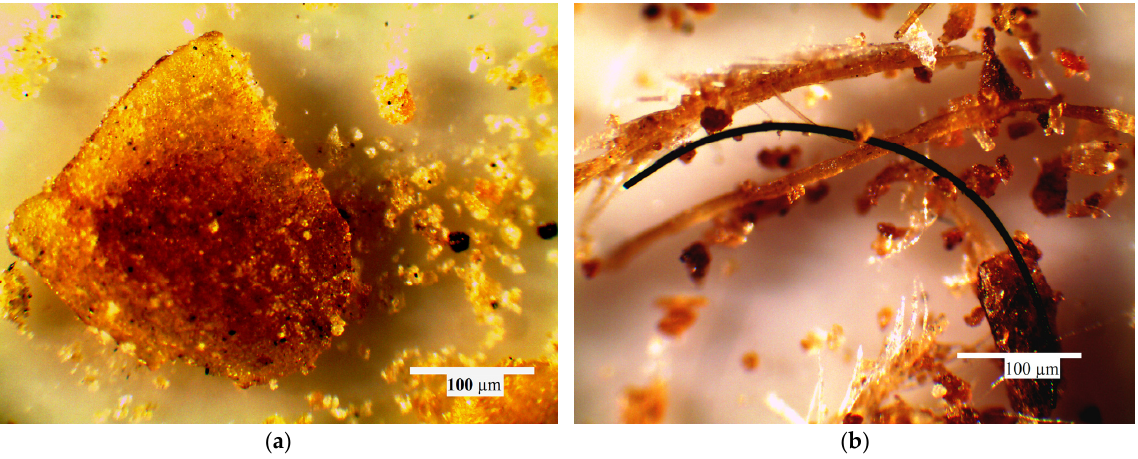
Figure 3. Pictures of the tested materials: ( a ) DDGS; ( b ) MBM.